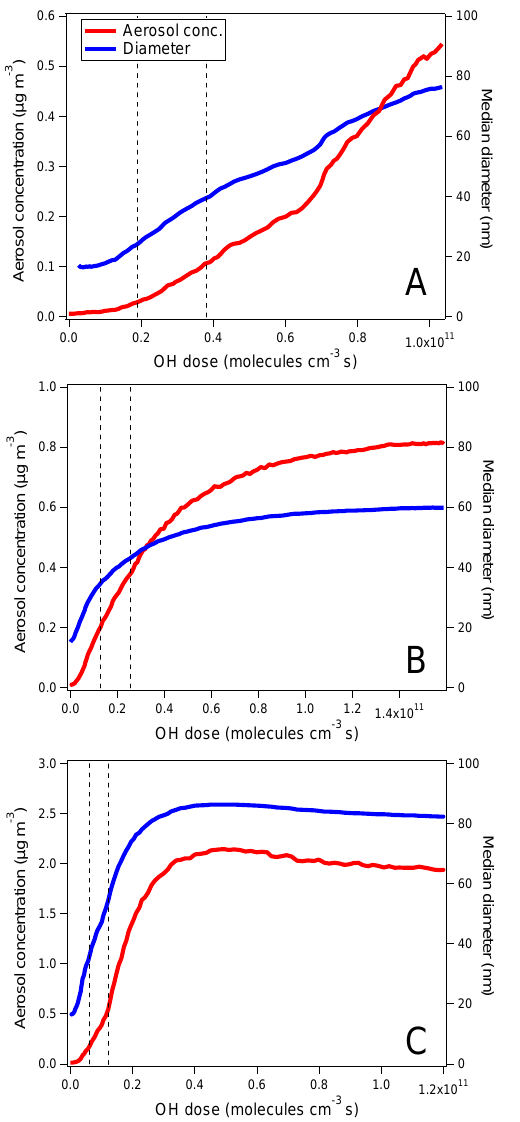
Figure 3. Time series of GE OH ( t ) (particle mass growth efficiency with respect to the reaction of OH with organics, refer to the text for details; for clarity, a 7 points moving average is shown), k OH (Org) (OH reactivity of total organics), O / C and H / C from AMS data, and aerosol mass concentration in the OH oxidation of α -pinene (a) , β -pinene (b) and limonene (c) . The shaded area shows the dark pe- riod. The dashed vertical lines in each panel show the one and two lifetimes of